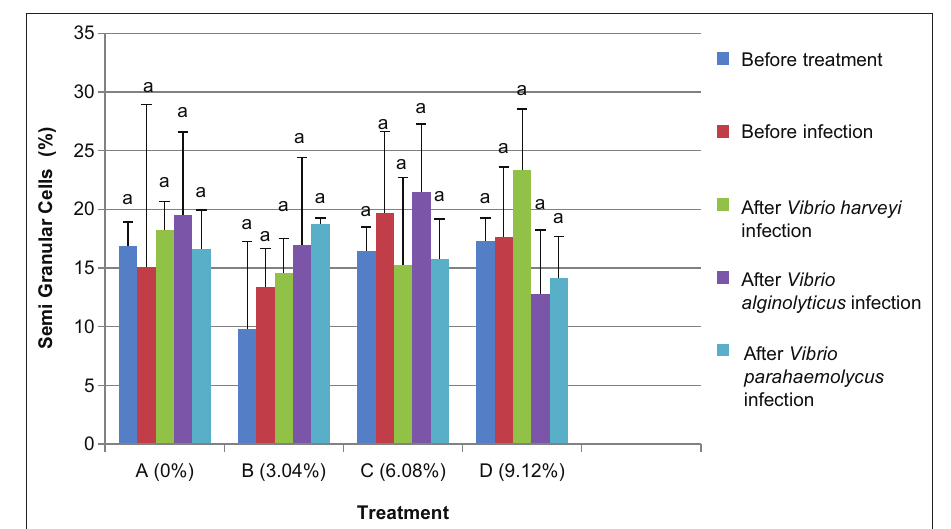
Figure-2: The number of semi-granular cells of vannamei shrimp ( Litopenaeus vannamei ) before and after infected with Vibrio harveyi, Vibrio alginolyticus , and Vibrio parahaemolyticus and treatment with Majapahit ( Crescentia cujete L.) fruit powder. Data were indicated as mean value±SD. Graphs with different notations showed significantly different (p<0.05).